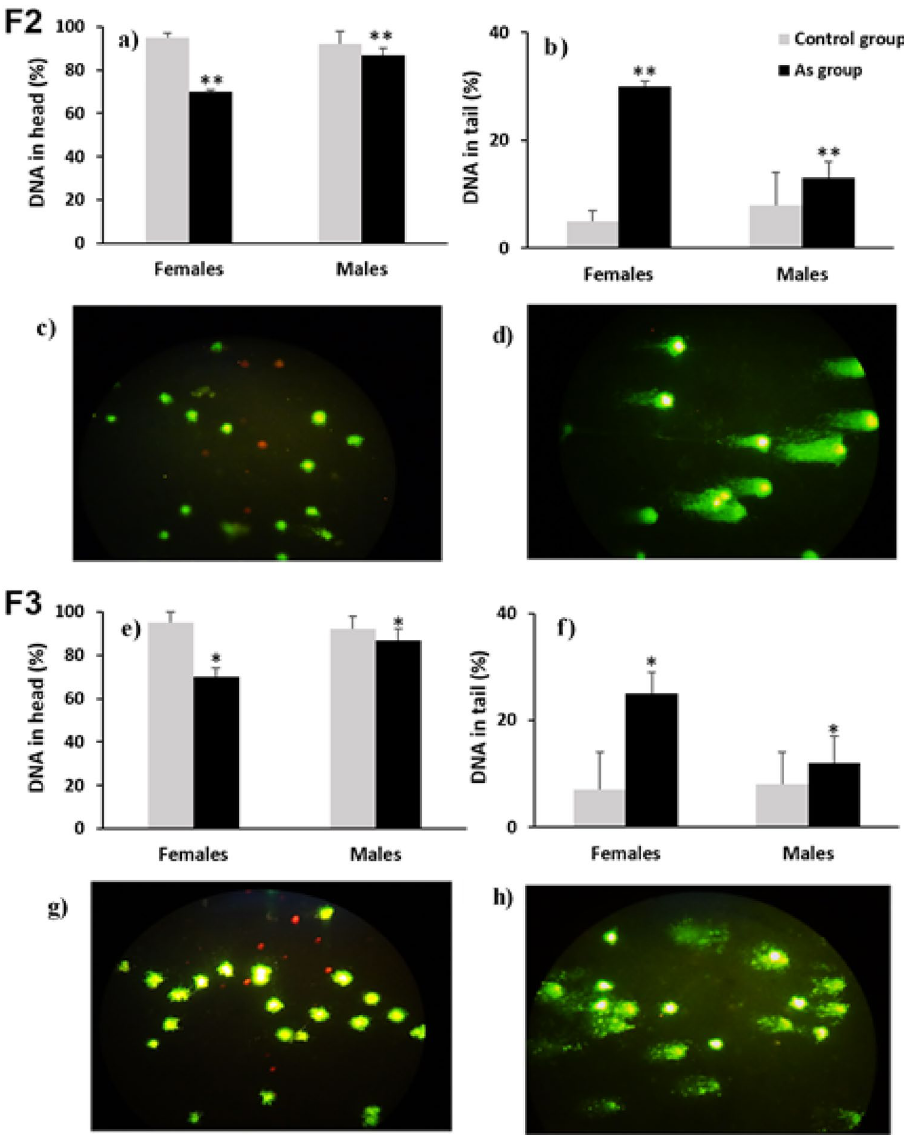
Figure 3. DNA damage in WBC assessed by comet assay (SCGE); ( a , e ) show the percentage of DNA in head (integrity) in males and females of the generations F2 (indirect exposed multigenerational lineage) and F3 (transgenerational lineage without partial or indirect exposure) respectively; ( b , f ) show the percentage of the DNA in tail (fragmentation) in males and females of generations F2 and F3 respectively. Grey bars: control group and linage (n = 24), black bars: As exposed group and linage (n = 24). (*), (**) statistically significant differences intra-gender between control and arsenic exposed group in each generation at p < 0.05 and p < 0.01 respectively. Error bars: standard deviation. ( c , g ) microphotographs of WBC without fragmentation (F2 and F3, respectively); ( d , h ) microphotographs of WBC with fragmentation (F2 and F3